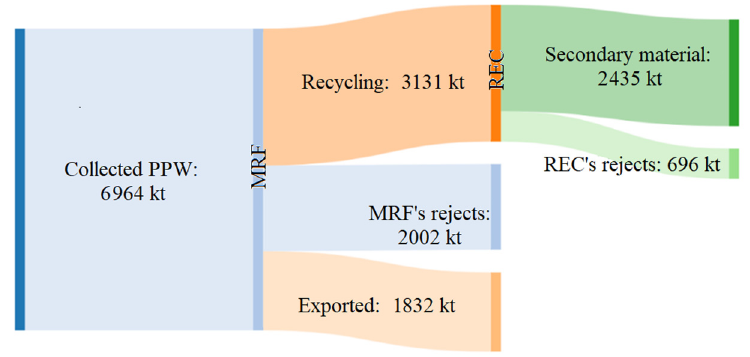
Figure 2. Material flow analysis of EU plastic packaging waste (PPW) in 2017 (kt). The analysis was conducted on five MRFs and eight RECs. Modified from [62]. MRFs: material recycling facilities; RECs: recycling plants.